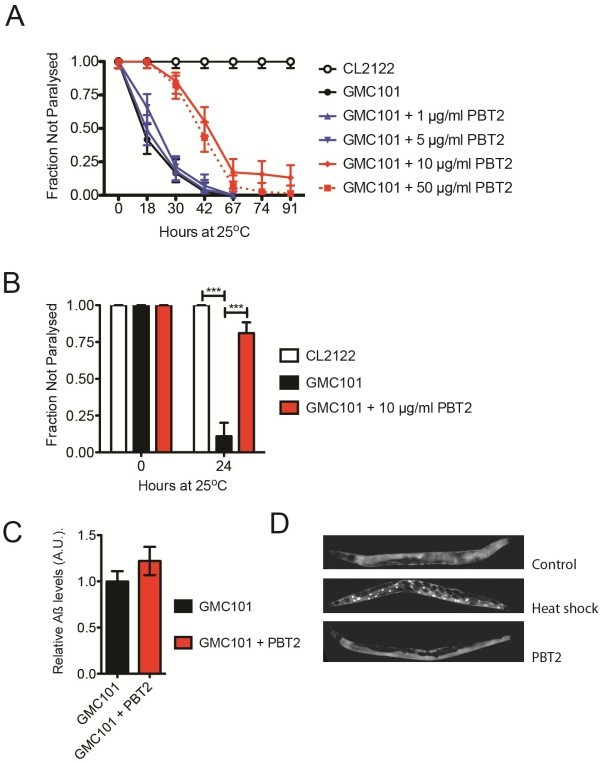
PBT2 protects against Aß1–42 induced toxicity. Paralysis associated with Aß1-42 expression is protected by PBT2. Plotted are the proportions of individuals not paralysed with upper and lower 95% confidence intervals. A PBT2 at 10 μg/ml was found to be most effective when cultures were exposed to compound for 24 prior to the initiation of the assay. B PBT2 effects are very rapid, such that immediate exposure to 10 μg/ml PBT2 suppressed Aß-induced paralysis. Control strain CL2122 (n = 74), Aß1-42 strain GMC101 (n = 73), GMC101 strain + PBT2 (n = 74), where n = number of individuals assayed and *** p < 0.001. Plot shown is representative of 3 experiments. C Exposure to 10 μg/ml PBT2 for 24 h did not significantly alter total Aß levels. Shown is mean ± SD quantitation via densitrometry of n = 3 immuno-blot analyses. D Exposure to PBT2 does not alter DAF-16 localization. Shown are representative epifluorescence micrographs of DAF-16: GFP cytoplasmic localization in Control and PBT2 (10 μg/ml for 24 h) treated populations in contrast to nuclear localization in samples heat-shocked for 2 h at 35°C.